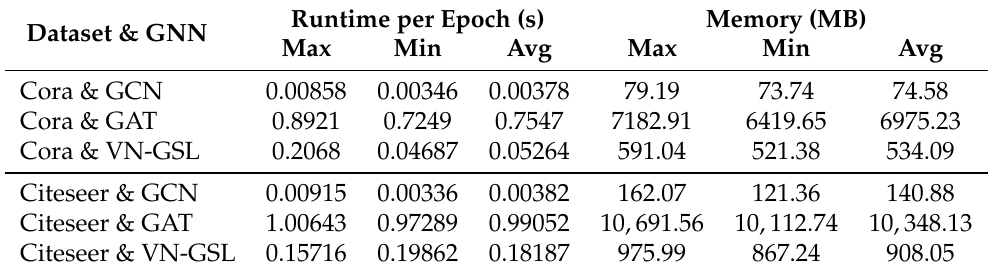
Table 3. Runtime and memory consumption on GCN, GAT, and VN-GSL.